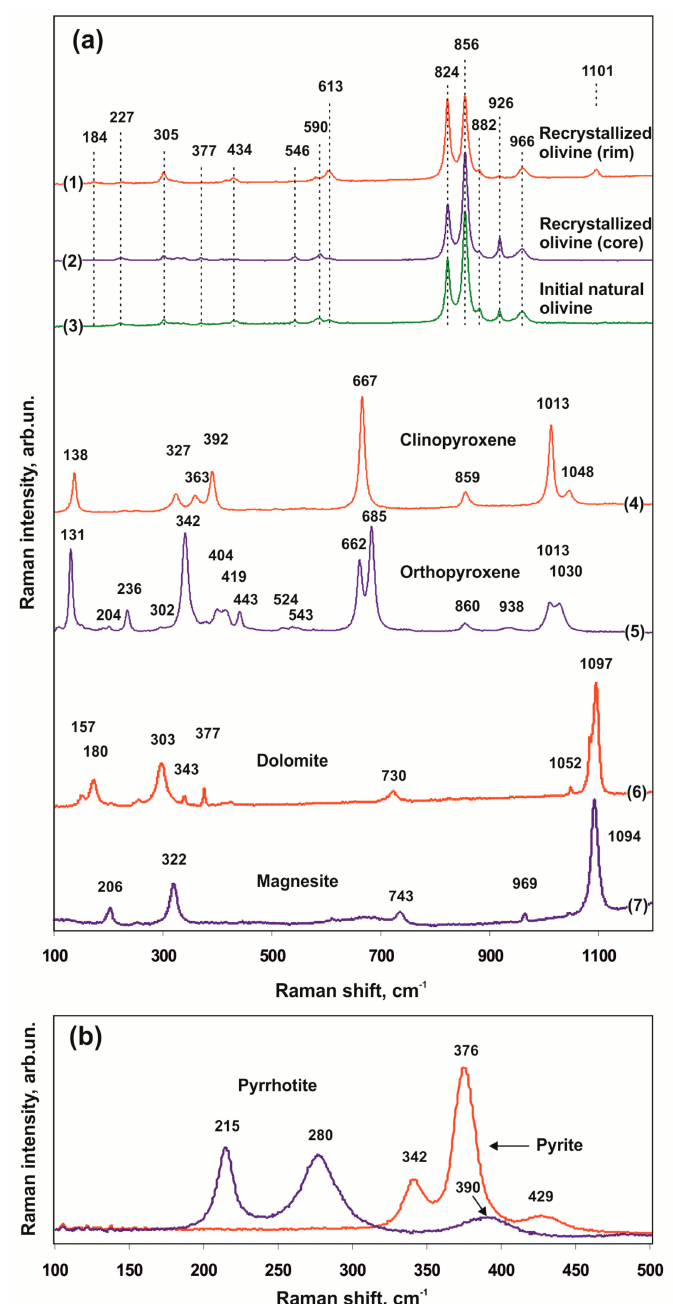
Figure 9. Representative Raman spectra (olivine-ankerite-sulfur system): ( a )—recrystallized olivine (1,2), starting natural olivine (3), newly formed phases—clinopyroxene (4), orthopyroxene (5), dolomite (6), and magnesite (7); ( b )—sulfides in inclusions in